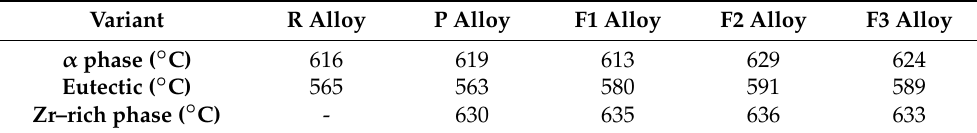
Table 4. Temperatures of structural components formation in R, P, and experimental melts